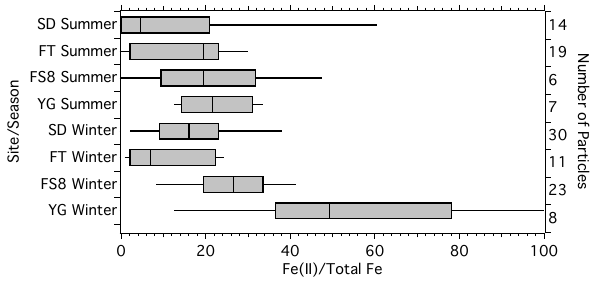
Fig. 2. Percentage of Fe(II) to total Fe (Fe(II) + Fe(III)) observed in single particles on filter samples are plotted for individual sites separated by season. 50th percentile (black line in box), 25th and 75th percentiles (lower and upper limit in box), 10th and 90th per- centiles (lower and upper whiskers) of each dataset are represented in this graph. The right axis represents the number of data points represented for each sampling site/season.